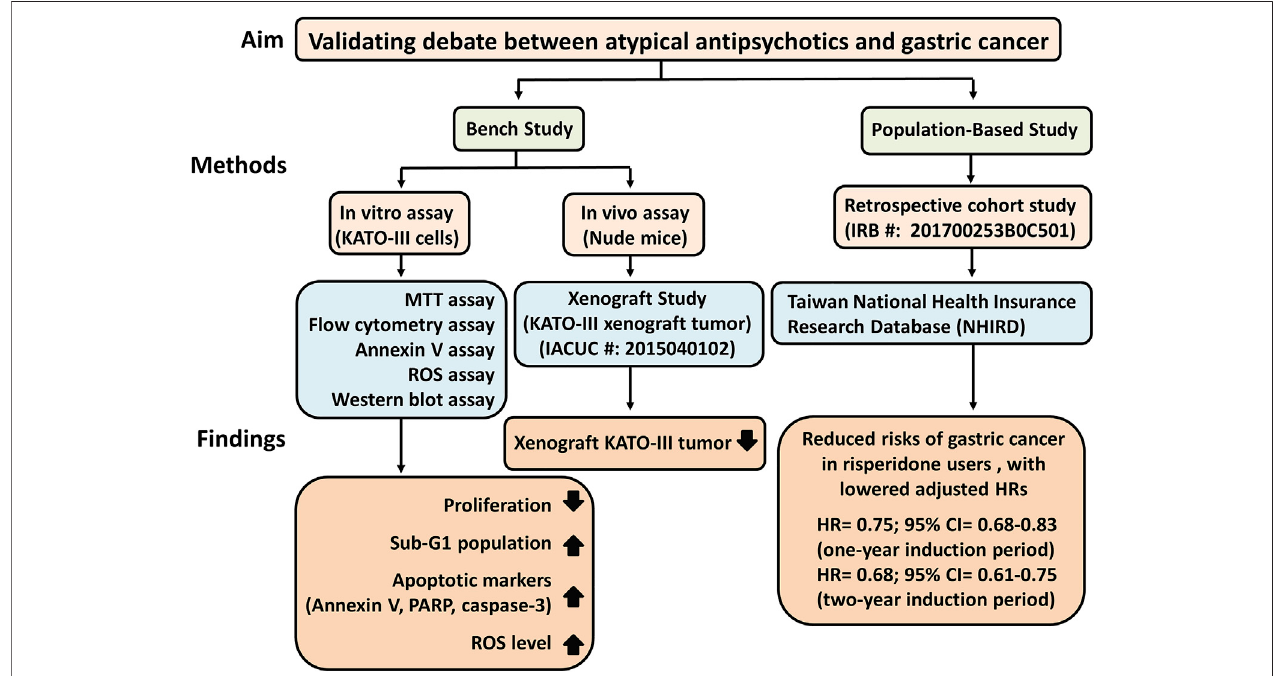
FIGURE 6 | Study schematic diagram of risperidone on gastric cancer. HRs, Lazard Ratios; CI, Con fi dence Interval.